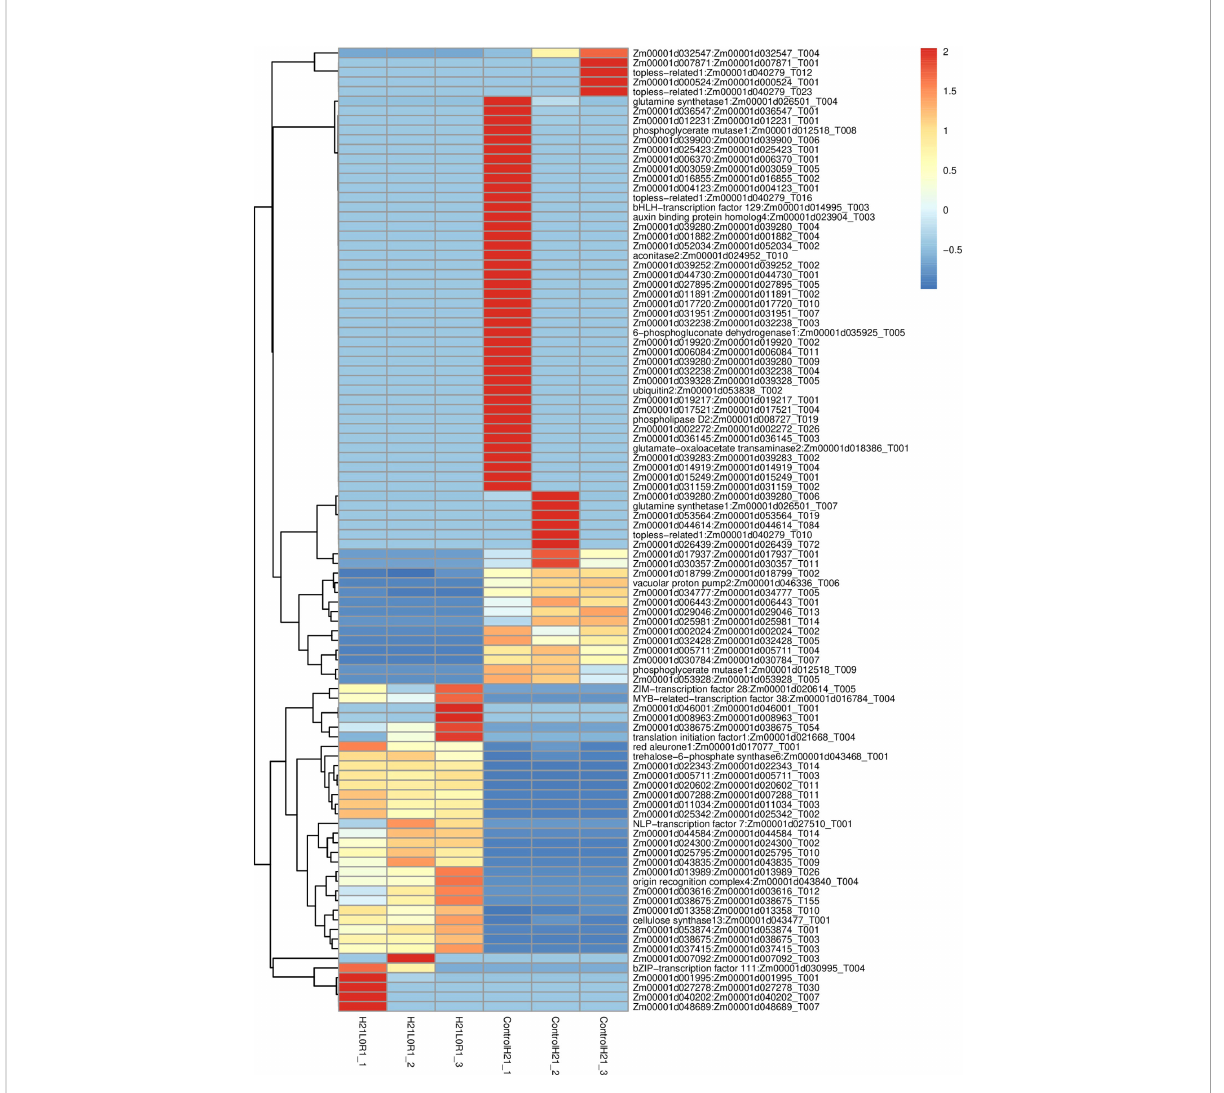
FIGURE 7 Transcriptomic pro fi ling reveals shared signaling networks in different samples of